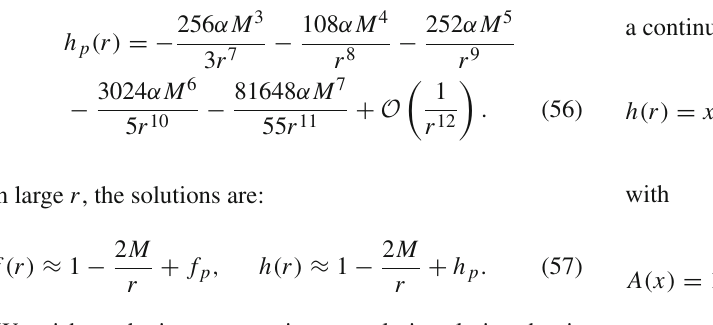
Fig. 8 The plots of metric for c 1 = − 0 . 25 ,α = 0 .